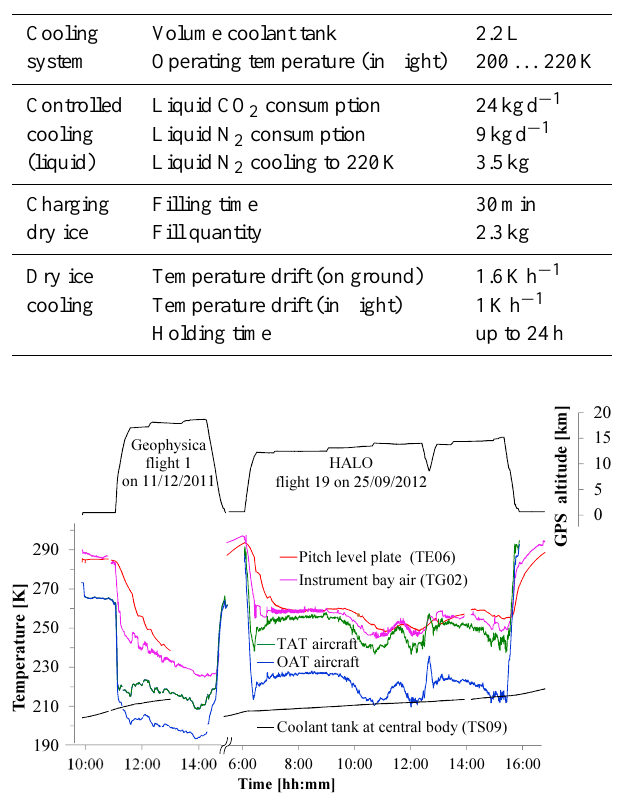
Figure 10. Ambient temperatures during typical operation of GLO- RIA on the Geophysica (left side) and HALO aircraft (right side). The evolution of ambient and instrument temperature is illustrated along flight altitude profile (OAT = temperature of undisturbed out- side air, TAT = includes the hydrodynamic temperature rise caused by the airplane velocity).